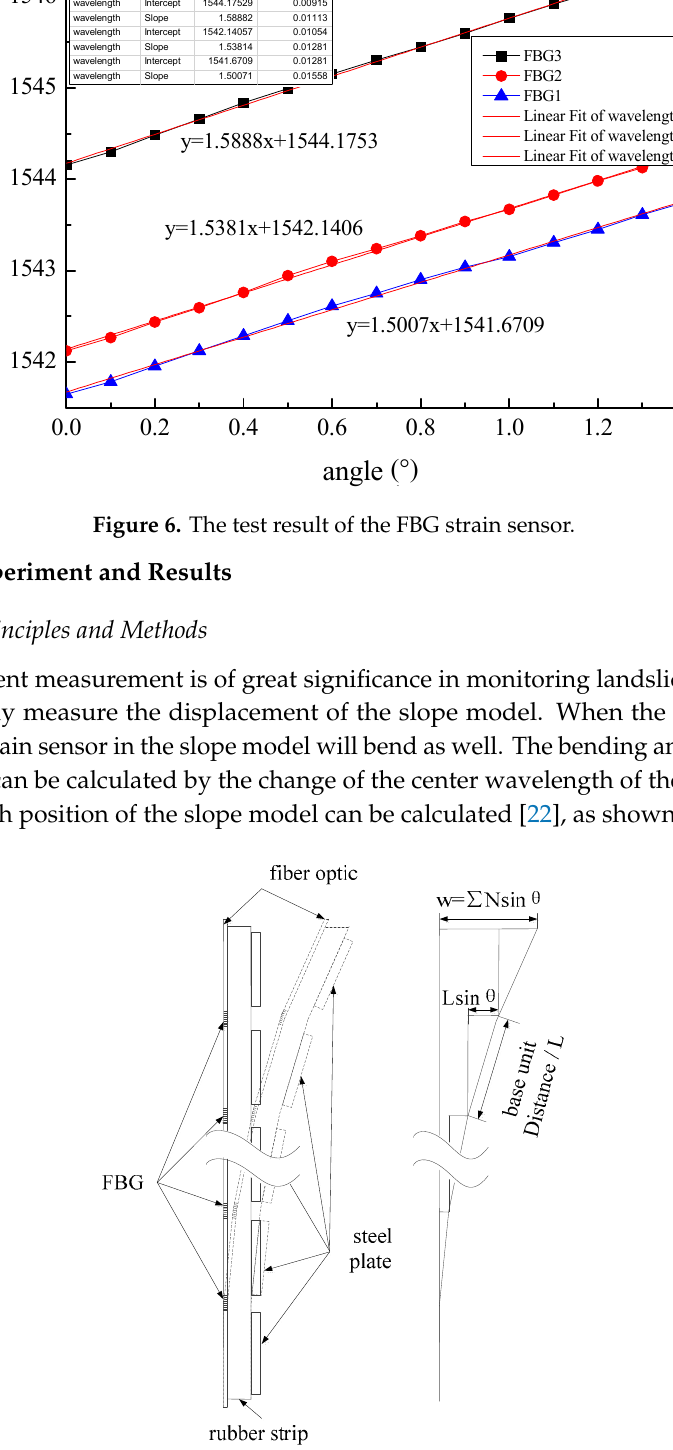
Figure 8. The photo of the FBG strain sensor used in the slope model monitoring. ( a ) the side of the rubber strip pasted with steel plates, ( b ) the side of the rubber strip pasted with FBGs. 5.2. Experimental Results and Analysis A model test was carried out to verify the performance of the FBG strain sensor by digging the backfill soil in a steel structure frame, as shown in Figure 9. The size of the test model was 3 m long, 1 m wide and 1.2 m high, while the excavation area was 0.4 m width and 0.6 m away from the left edge of the test model. To increase the deformation of the model, a uniform load of 14 kN was applied on the right side of the excavation area. A series of MPDMs was equipped to monitor its deformation during the excavation process in the model test. Meanwhile, an acrylic plate was set at the excavation boundary to install the sensor conveniently, and one end of the MPDM and the FBG strain sensor were installed on the acrylic plate. The excavation model tests were carried out in three stages with each excavation depth of 15 cm, 30 cm, 45 cm, respectively. The displacement measurements by using these two methods were shown in Figure 10. The obtained results are shown in Figure 11, which presents obvious differences in the monitoring result. A finite element model (FEM) was applied to analyze the deformation of the test model, as shown in Figure 12. Besides, the deformation of the FEM was compared with the MPDM monitoring results. It is found that, the deformation results calculated by the FEM are similar to the MPDM monitoring results, as shown in Figure 13.